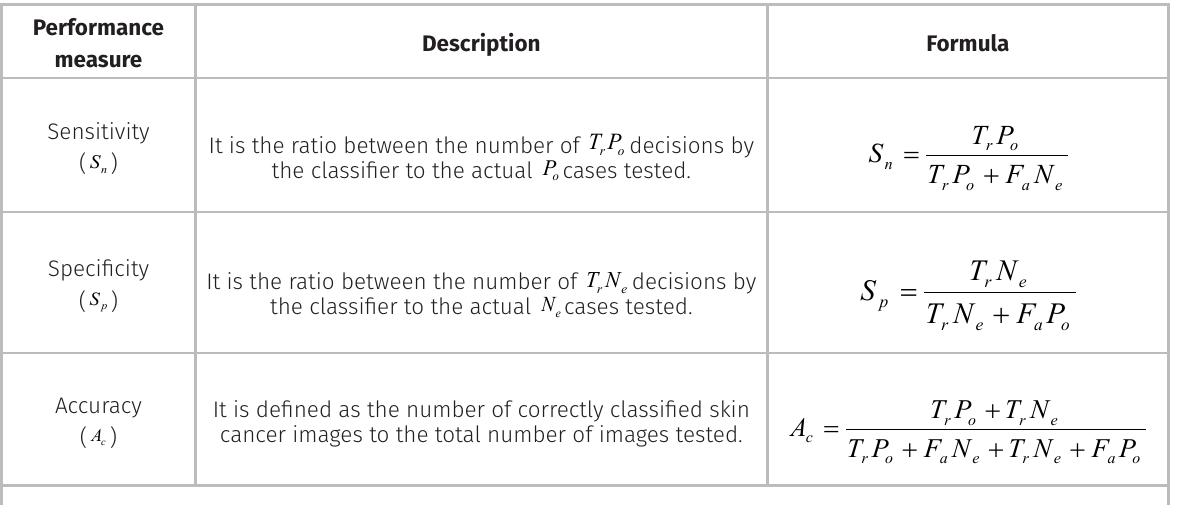
Table I. Performance matrices of SCC